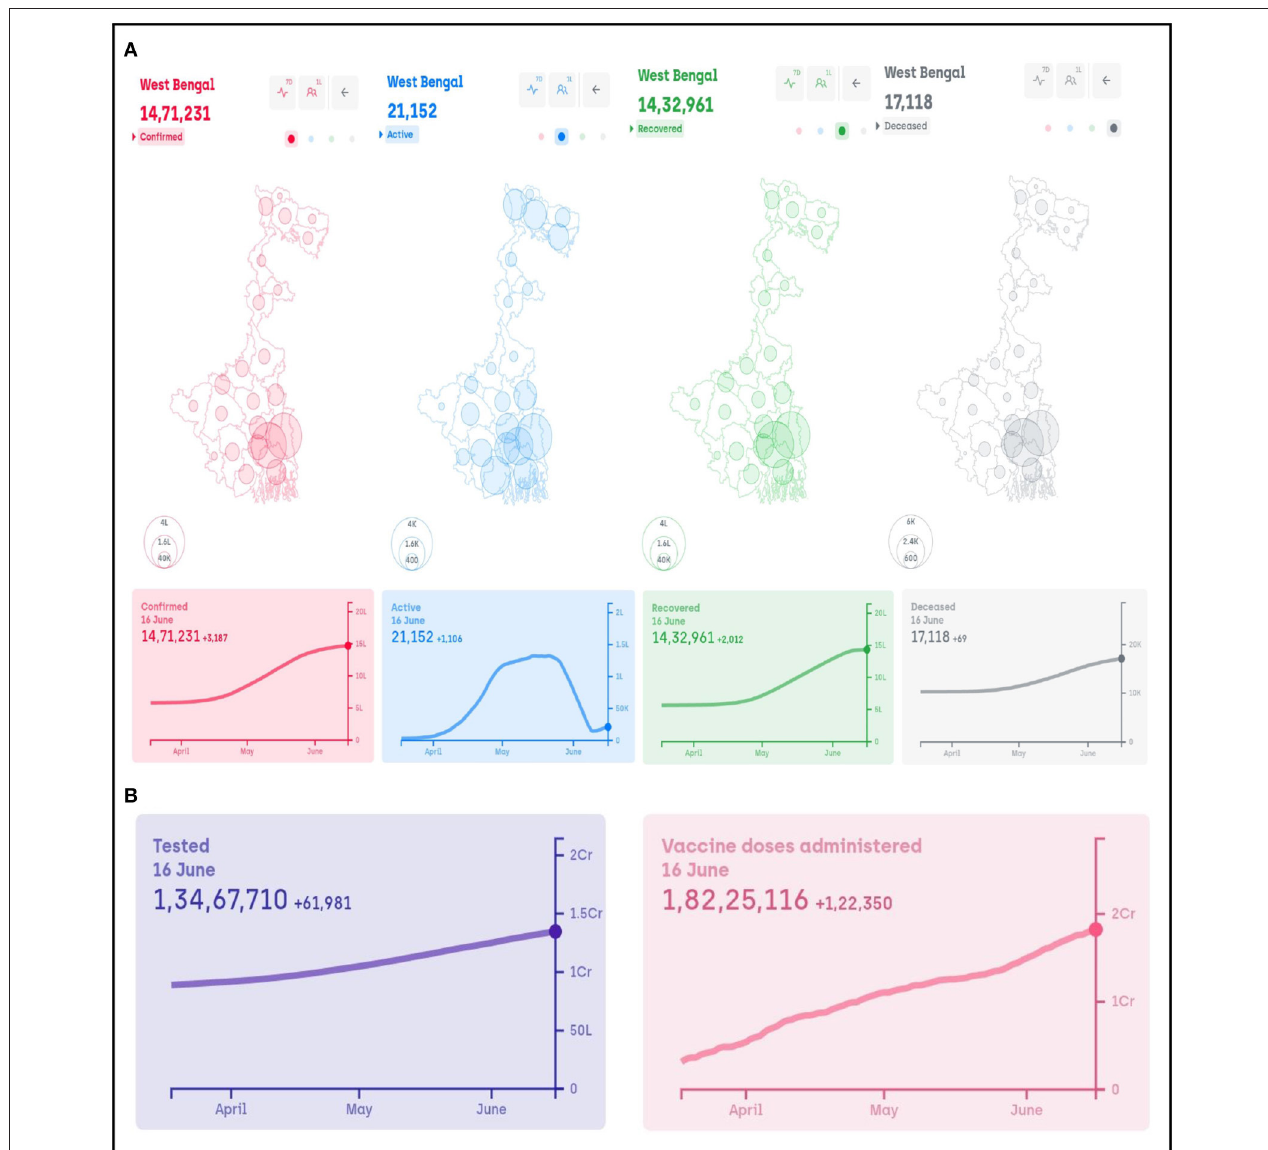
FIGURE 2 | West Bengal: (A) number of confirmed, active, recovered and deceased cases and (B) total number of people tested and vaccine doses